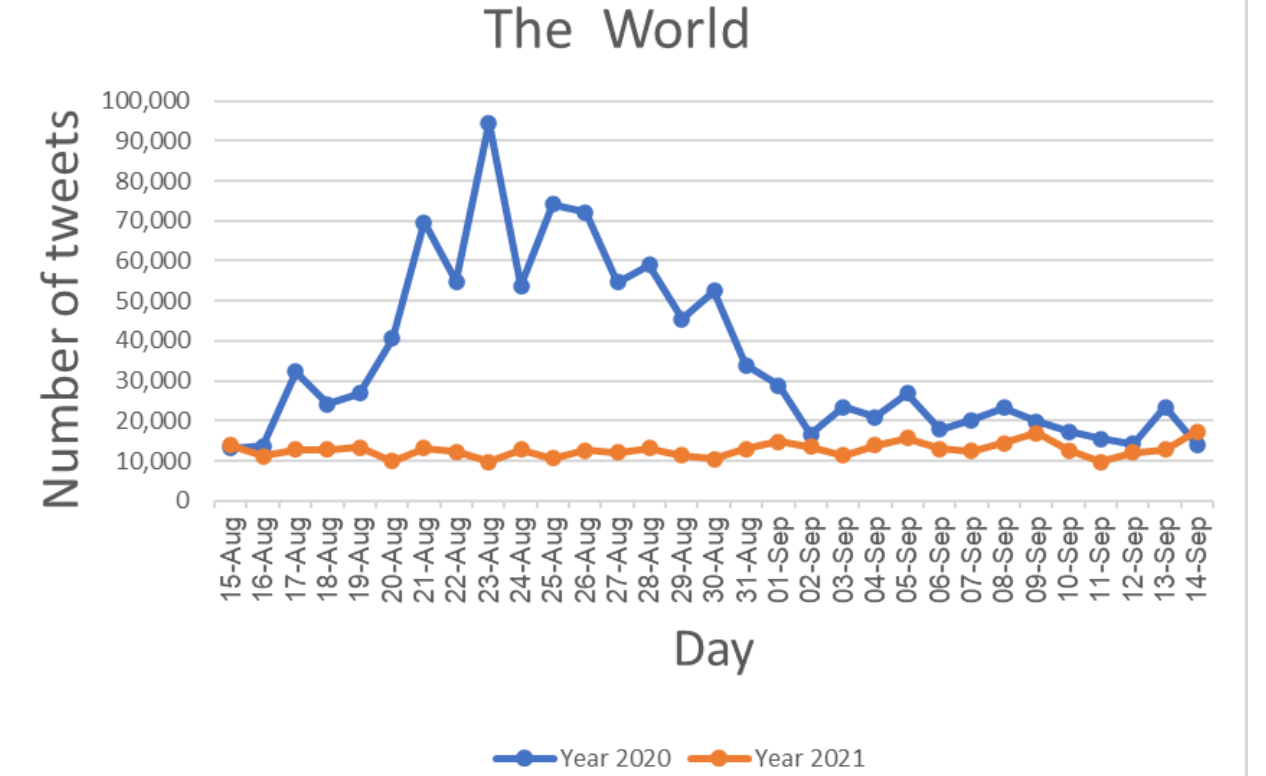
Figure 8. Frequency of education tweets between August 15 and September 15 for 2020 and 2021.